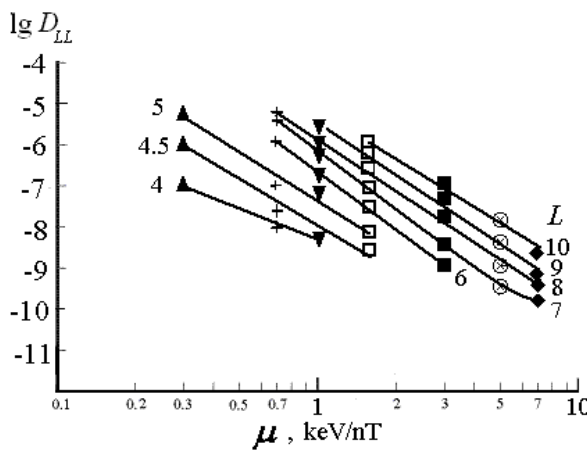
Figure 7. The dependence of the D LL on µ for L = 7. The thick curve corresponds to the results given in Fig. 5. The thin curves correspond to Eq. (6) for the electric diffusion. The lower horizontal line is the value of D LL in Nakada and Mead (1965), and the upper line is the value of D LL in Tverskoy (1965, 1969). Here D LL is given in values per second.